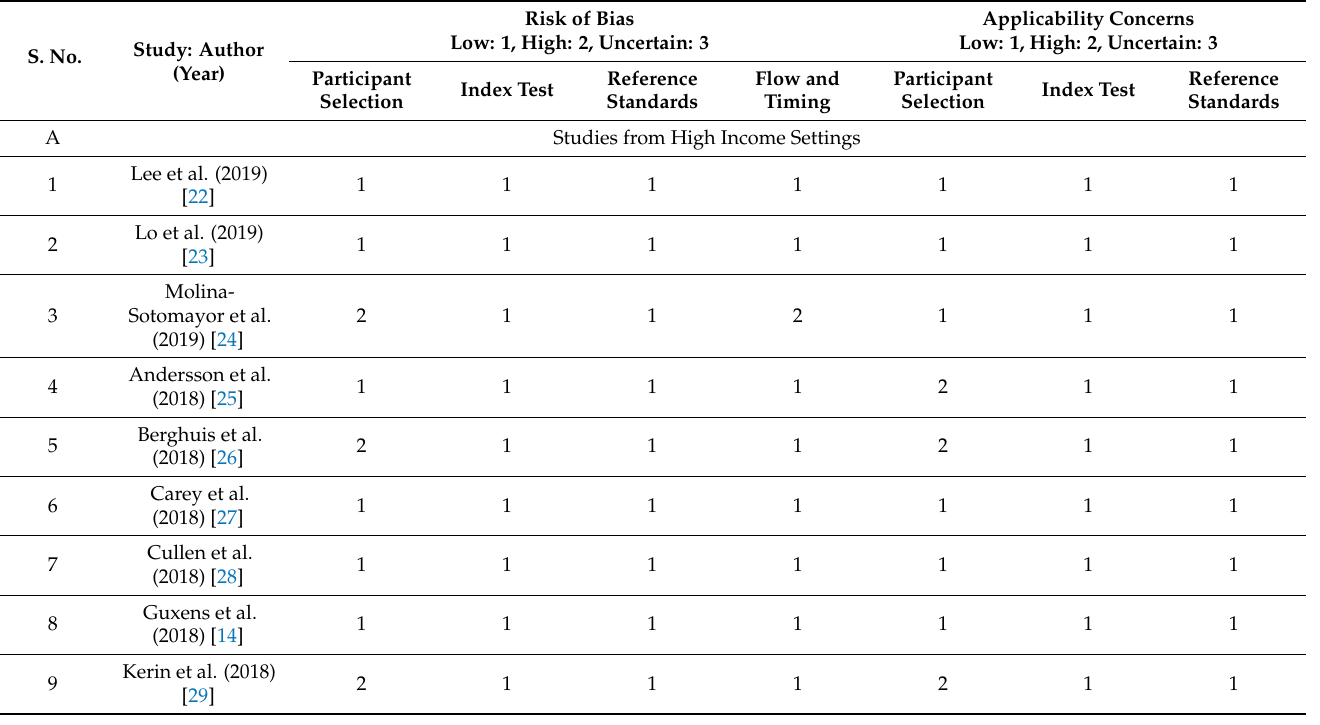
Table 2. Analysis of publication bias in published literature on cognitive impact of air pollution using the QUADAS-2